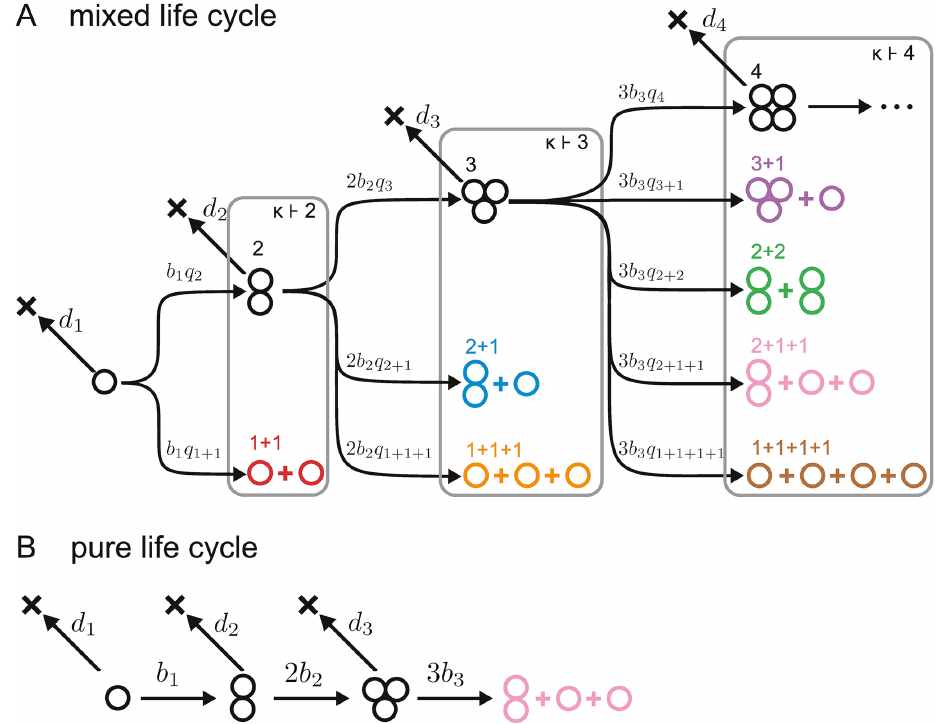
Fig 1. Life cyclesand fragmentation modes. A Cells within groupsof size i divide at rate b i , hence groups grow at rate ib i ; groups die at rate d i . The sequences b i and d i define the fitness landscapeof the model. We consideran exhaustiveset of possiblefragmentation modes, comprisingboth pure and mixed life cycles. In general,when growingfrom size i to size i + 1, groups stay together with probability q i +1 , or fragment accordingto fragmentation pattern κ with probability q κ . Each fragmentation pattern (determiningthe number and size of offspring groups) can be identified with a partition of i + 1, i.e., a way of writing i + 1 as a sum of positive integers, that we denote by κ ‘ i + 1. B Pure fragmentation modes are strategies with degenerate probabilitydistributionsover the set of partitions (so that q κ = 1 for exactly one fragmentation pattern, including staying together). Here we illustrate the pure fragmentation mode 2 + 1 + 1, for which q 2 = q 3 = q 2+1+1 = 1, and q κ = 0 for all other κ